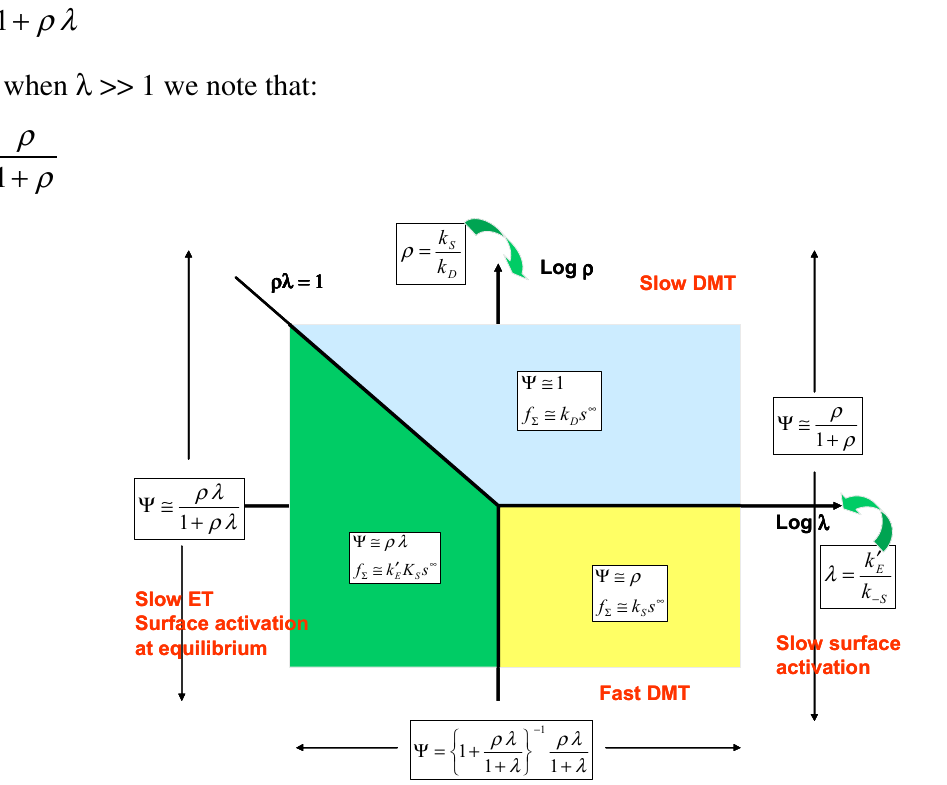
Figure 6. Kinetic case diagram for the general Koutecky-Levich